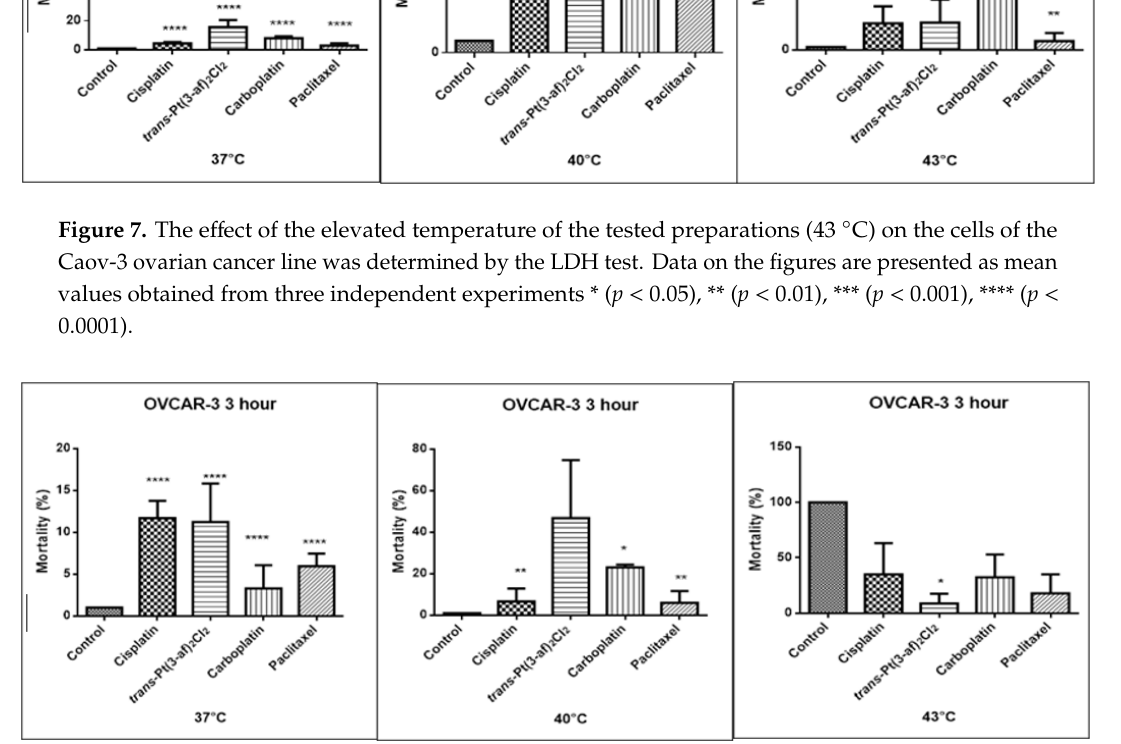
Figure 8 . The effect of elevated temperatures on OVCAR-3 ovarian cancer cells was determined by the LDH test. Data on the figures are presented as mean values obtained from three independent experiments * ( p < 0.05), ** ( p < 0.01), **** ( p < 0.0001).